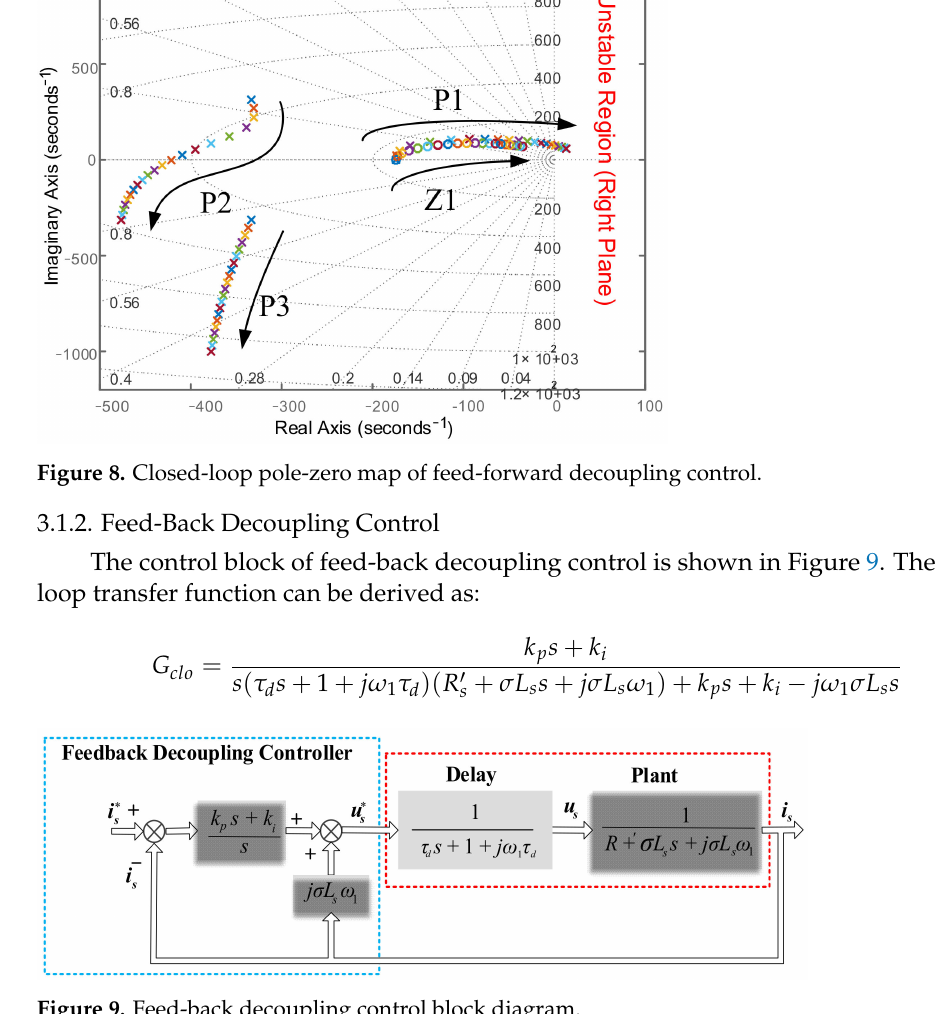
Figure 9. Feed-back decoupling control block